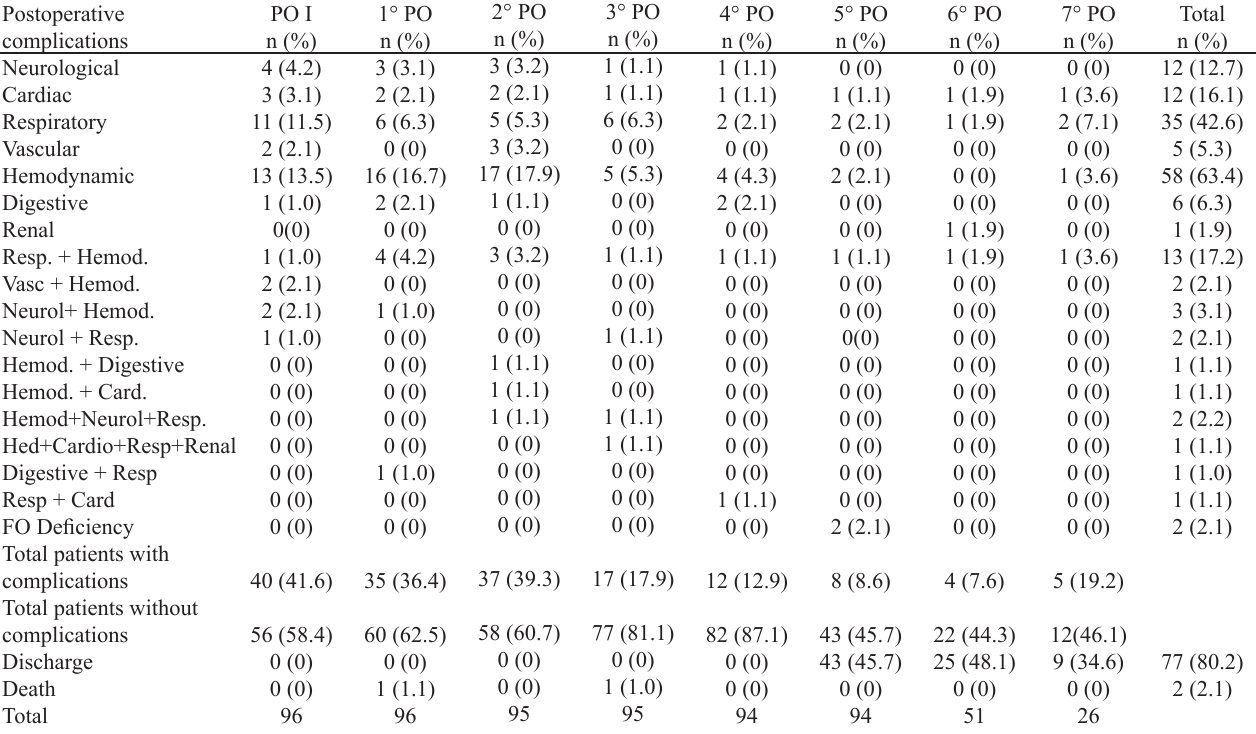
Table 2. Characterization of postoperative complications in cardiac surgery according to the days of hospitalization (n = 96). Postoperative